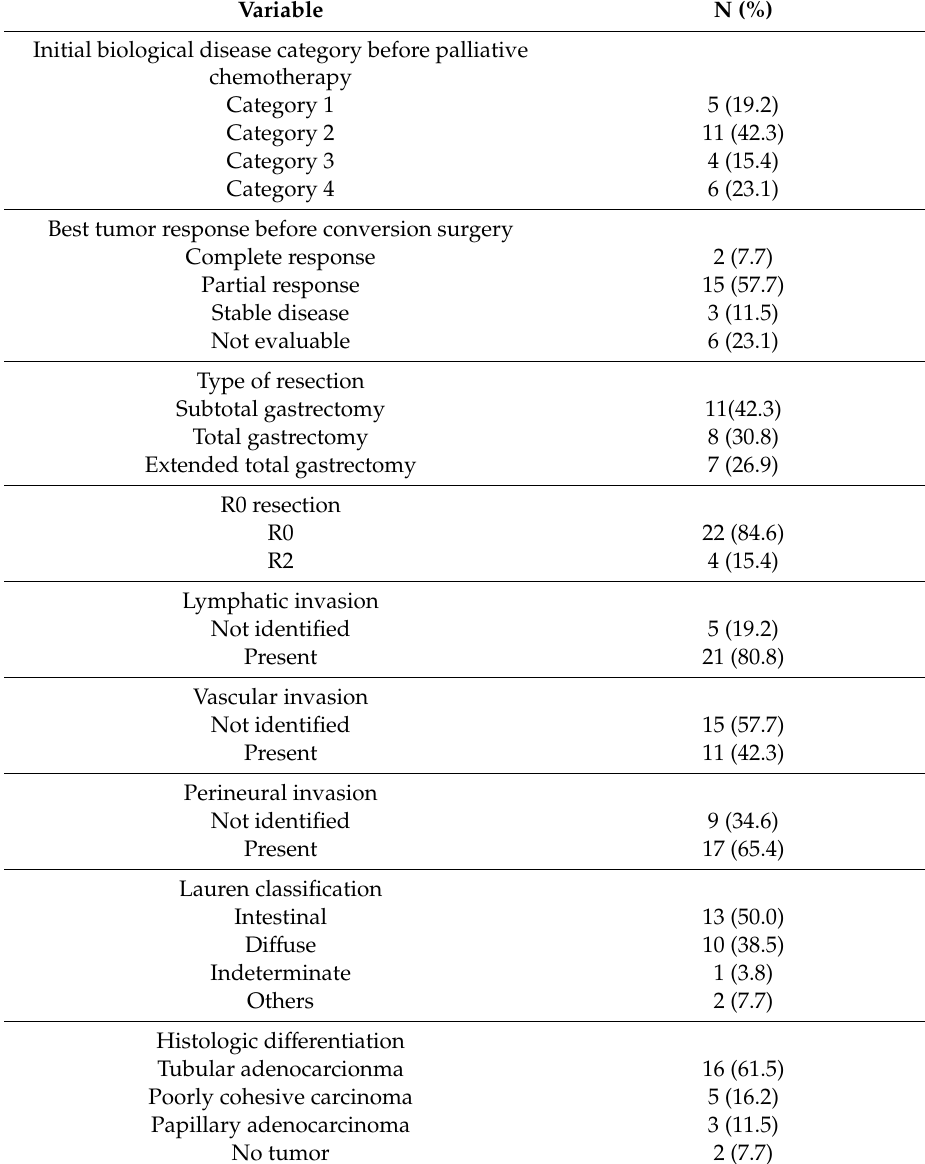
Table 2. Clinicopathological characteristics of tumor in conversion surgery